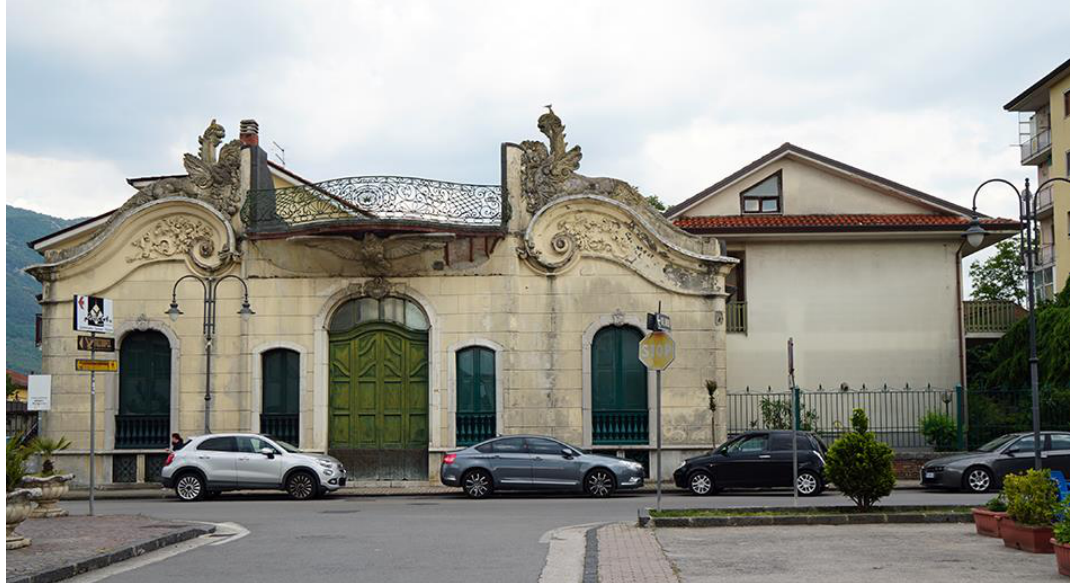
Figure 60. San Michele di Serino: “Mariconda” palace facade, one of the few historical facades not destroyed by the 1980 earthquake (photos by [35,36]).